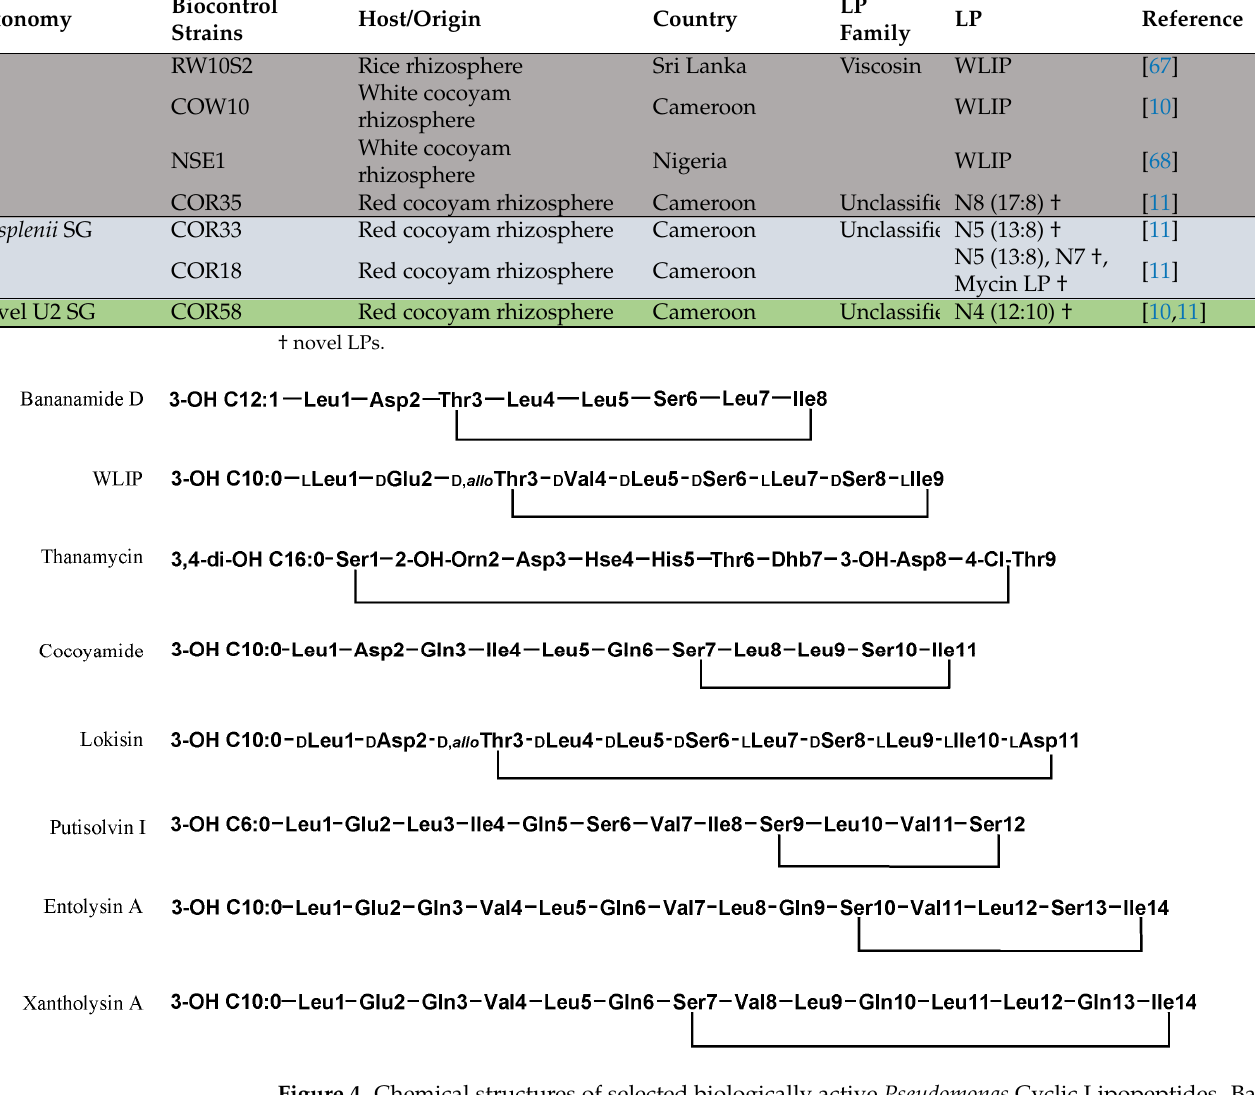
Figure 4. Chemical structures of selected biologically active Pseudomonas Cyclic Lipopeptides. Ba- nanamide D (Bananamide Group); WLIP (Viscosin Group); Thanamycin (Syringomycin Group); Lokisin (Amphisin Group); Cocoyamide; Putisolvin I; Entolysin A and Xantholysin A. Whenever